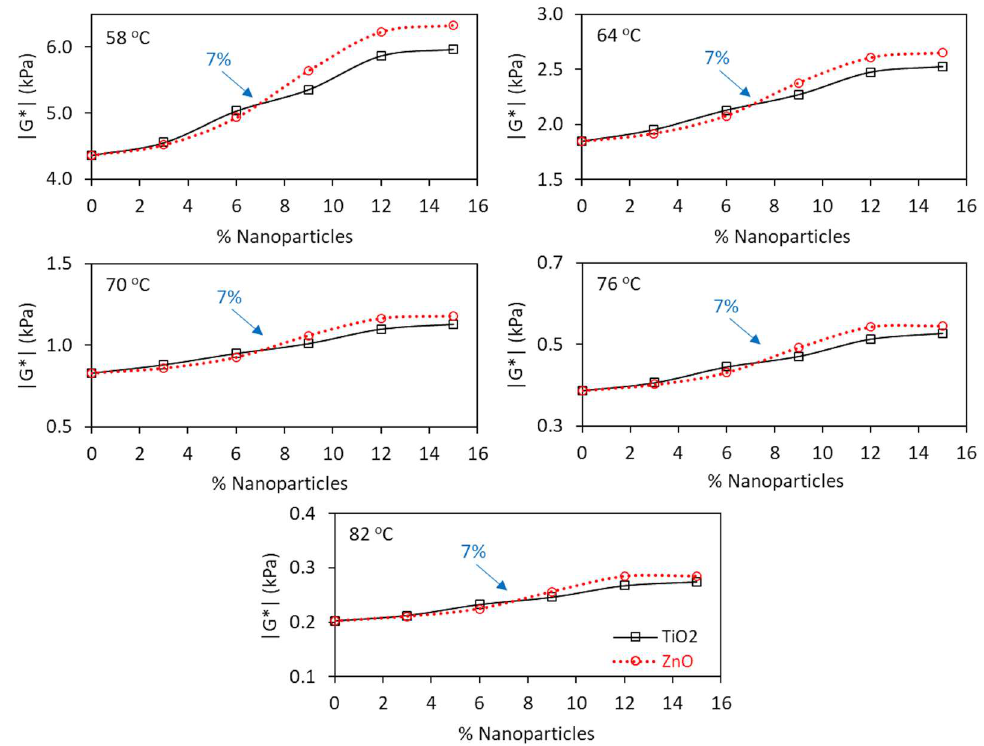
Figure 5. Comparison of the effect of the percentage of TiO 2 and ZnO on the dynamic shear modulus (|G*|) of conventional binder short-term aged at high temperatures (58 °C to 82 °C).